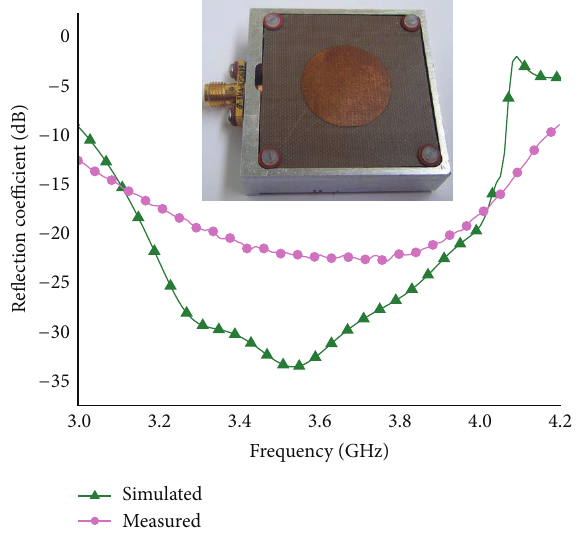
Figure 9: Reflection coefficient of the proposed antenna.